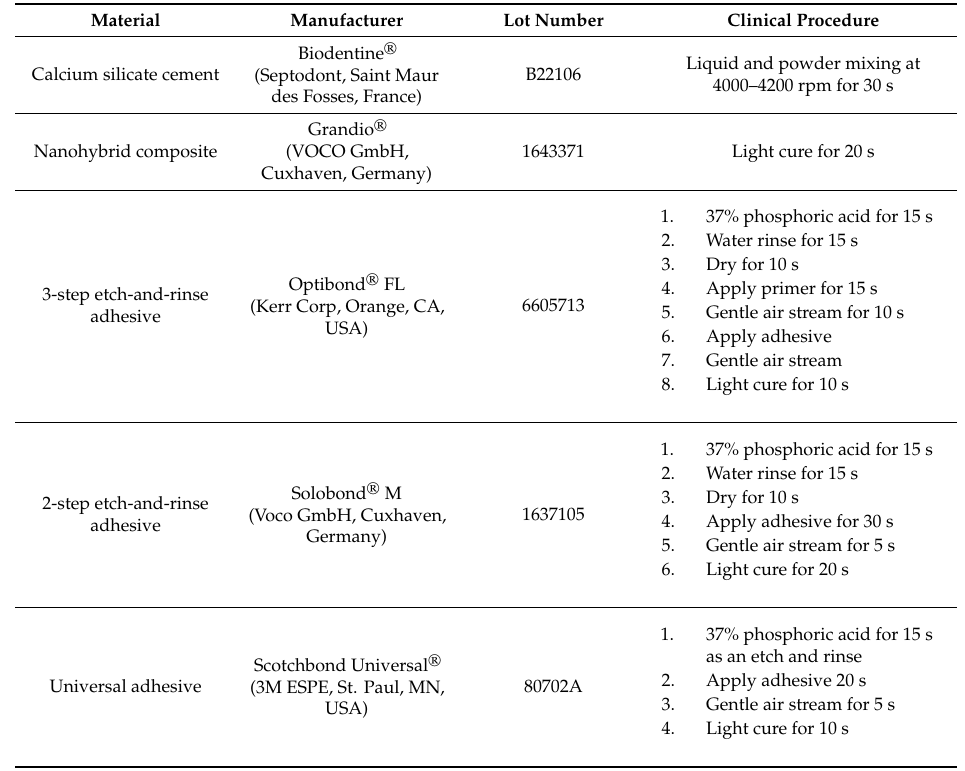
Table 1. Overview of the investigated